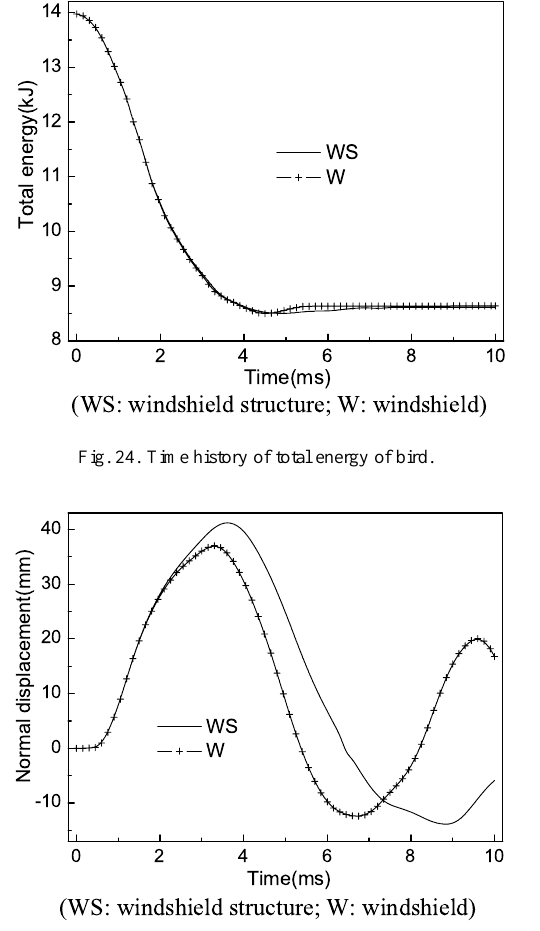
Fig. 25. Time history of normal displacement at the center on inner surface of windshield.